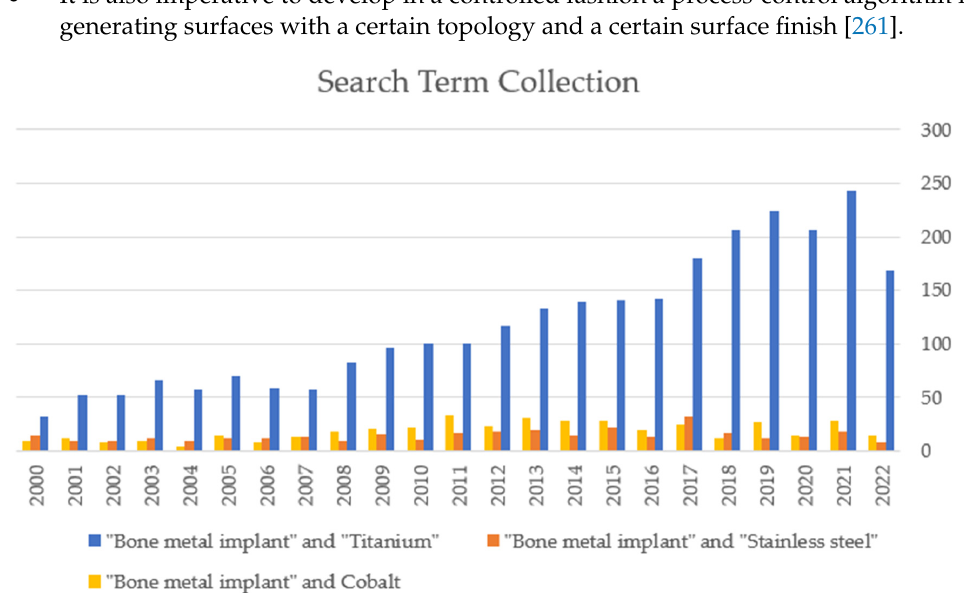
Figure 16. Number of publications for each search term in the Scopus online database.